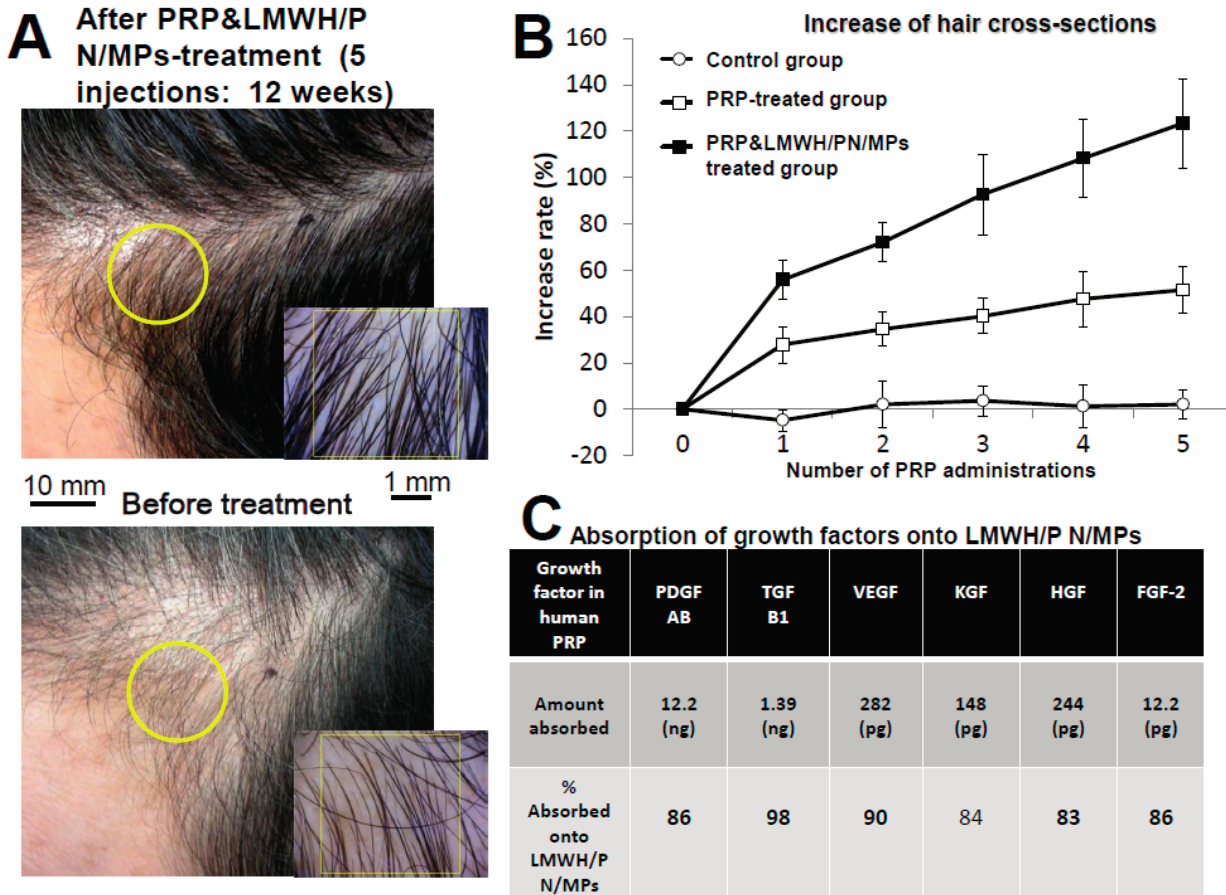
Figure 4. GFs from PRP and LMWH/P N/MPs treatment for ordinary baldness. ( A ) An appearances of hair before and after GFs from PRP and LMWH/P N/MPs-treatment (five injections for 12 weeks); ( B ) Hair cross-sections after administration of GFs from PRP and LMWH/P N/MPs ( ■ ), GFs from PRP alone ( □ ), and saline alone (control: ○ ); ( C ) Binding of GFs onto LMWH/P